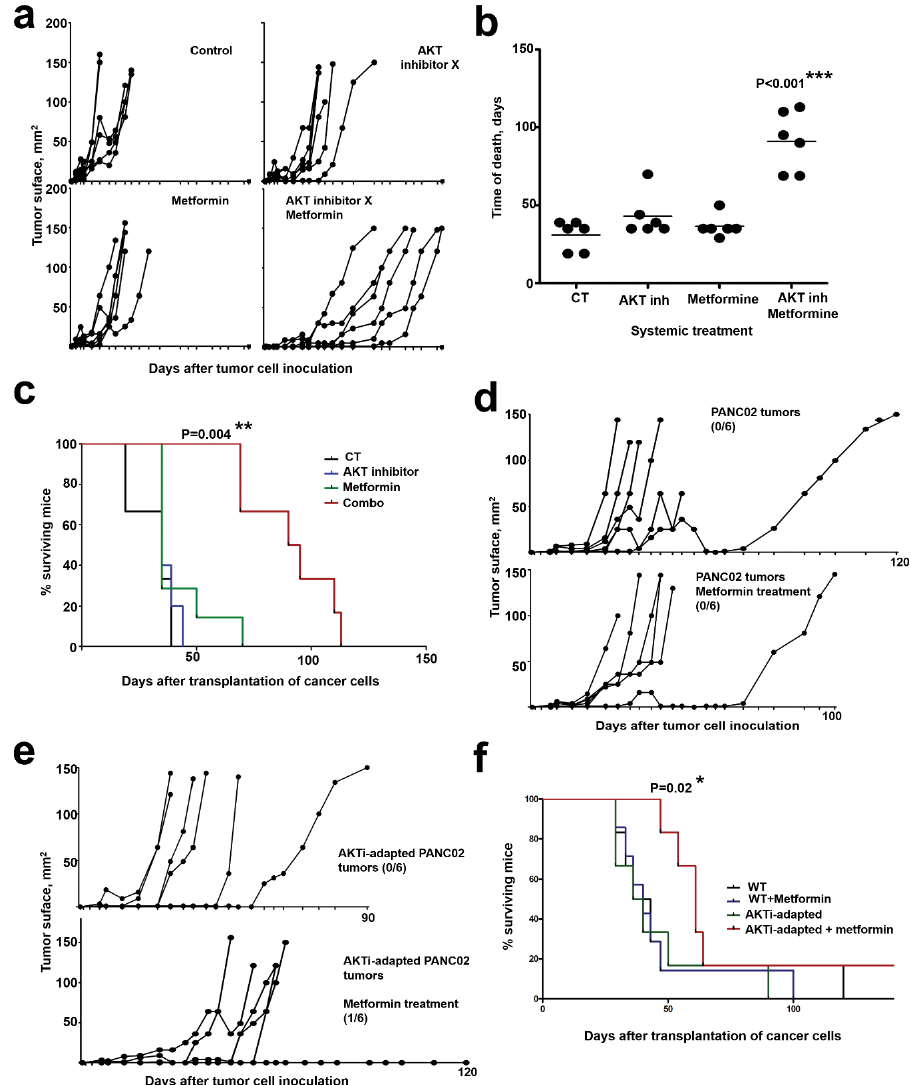
Figure 8. In vivo targeting of AKT and mitochondrial activities synergize in counteracting tumor growth. ( a ) PANC-02 tumor growth in individual mice (n = 6) from the indicated treatment groups. Drugs were administered twice subcutaneously. Control group, PBS-treated mice. ( b ) As in ( a ), but representing the time of death of each mice within the indicated treatment groups. Relevant statistical comparisons were performed with one-way ANOVA and Tukey´s a posteriori test, and shown within the graph. ( c ) Kaplan-Meier survival plot of the treatment groups, as indicated. ( d ) As in ( a ) but with metformin-only treatment in PANC02 tumors or with AKTi-adapted PANC02 tumors ( e ) . The number of tumor-free mice/total mice are shown within the corresponding treatment groups. ( f ) Kaplan-Meier survival plot of the treatment groups as indicated. Relevant statistical comparisons were performed with. *, **, ***, indicate significant ( p < 0.05), very significant ( p < 0.01) and highly significant ( p < 0.001) differences. 2.6. In vivo AKT Inhibition Together with Metformin Treatment Increases Therapeutic Efficacy Our results suggest that dual inhibition of AKT and mitochondrial activities in vivo should inhibit tumor progression more effectively than monotherapies, and prolong survival in pre-clinical models of pancreatic cancer. To test this hypothesis, we first subcutaneously transplanted murine